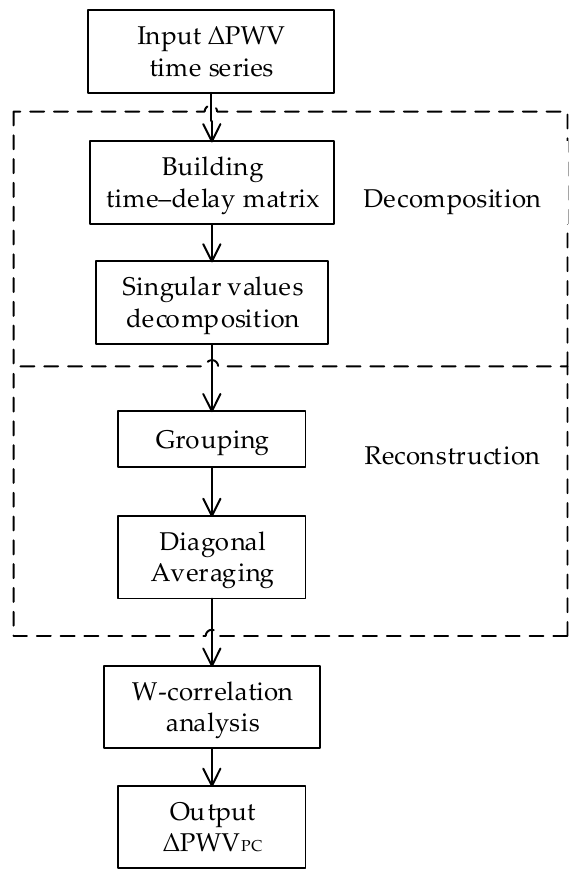
Figure 3. The main steps of singular spectrum analysis (SSA) analysis.